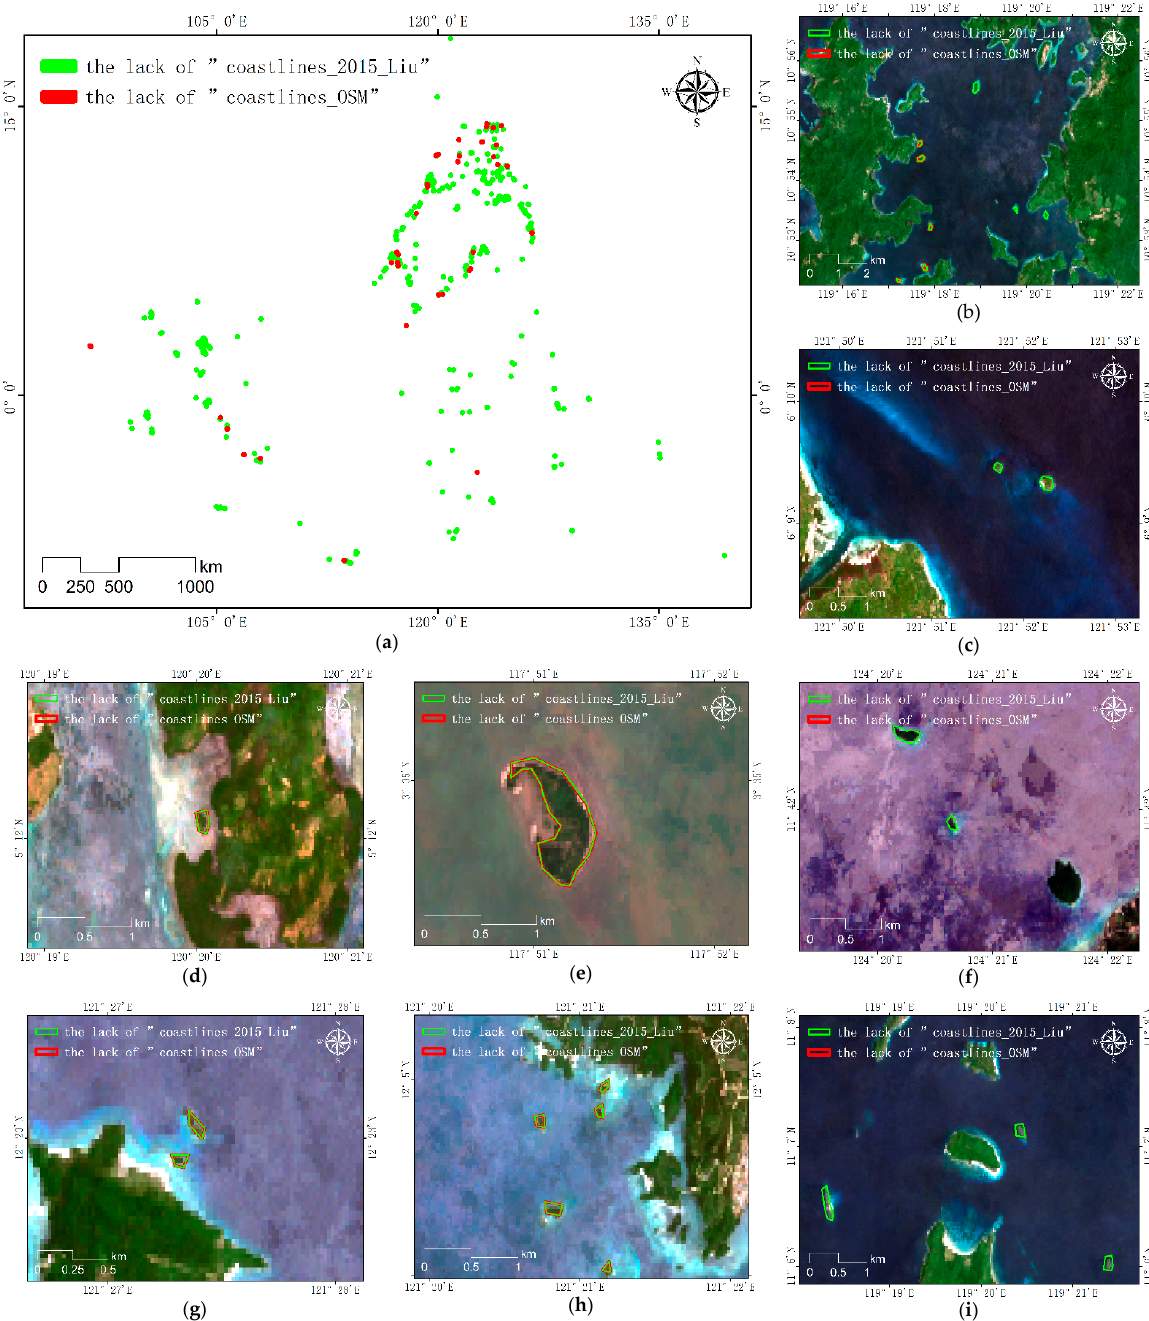
Figure 9. Supplement to missing islands data. ( a ) the location distribution of all missing islands; and ( b )–( i ) examples of verifying the existence of islands based on remote sensing images.